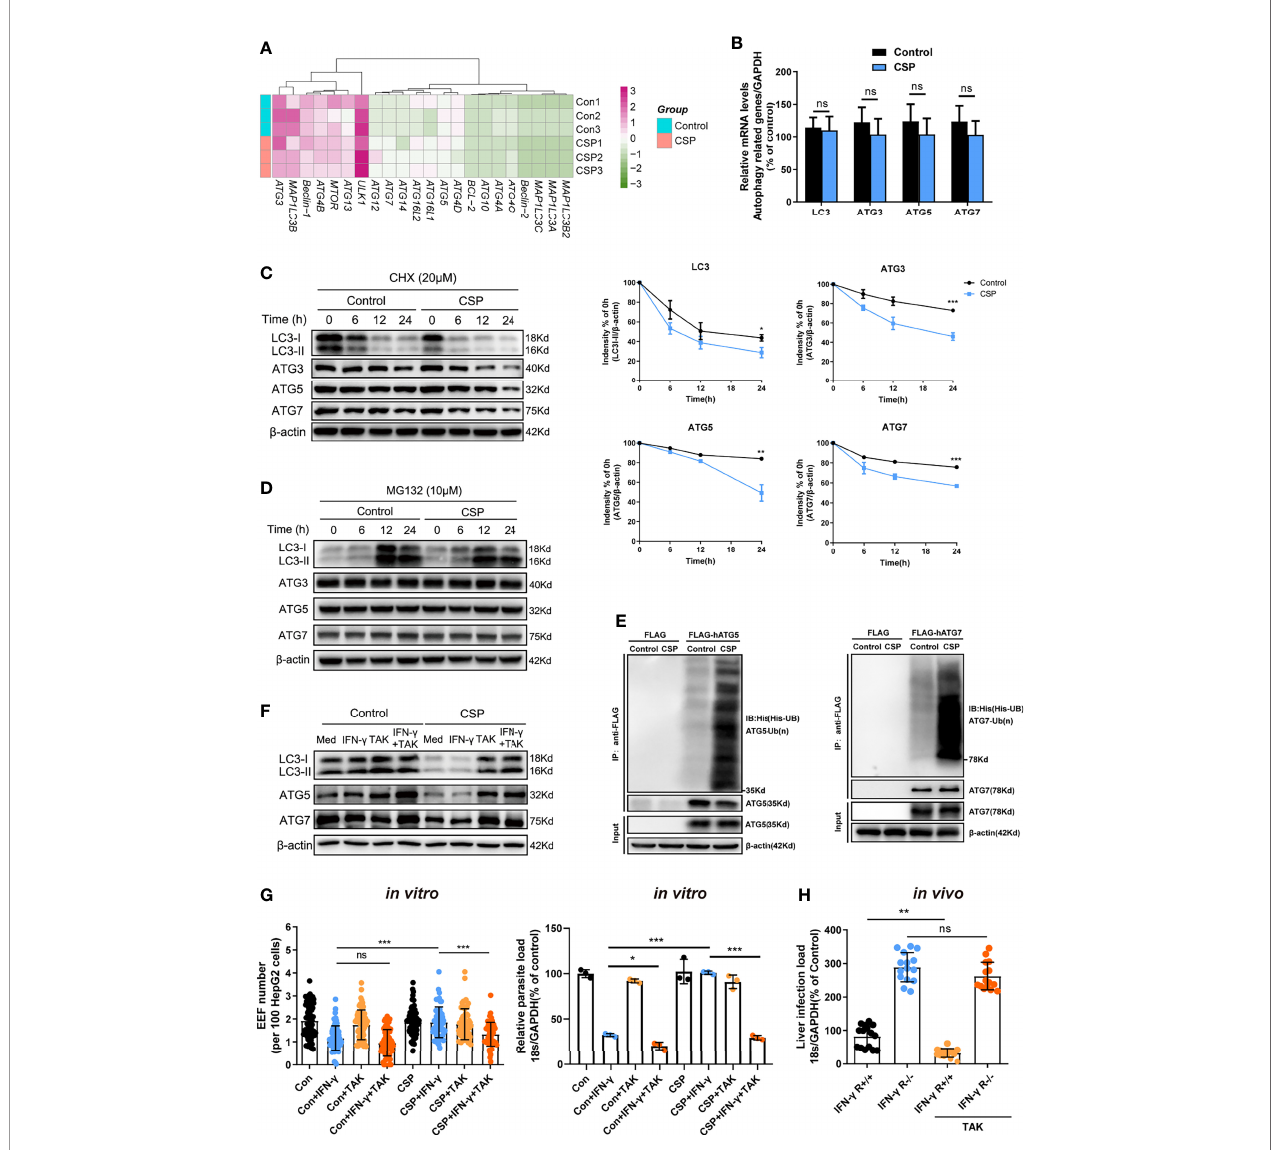
FIGURE 4 | The CSP-mediated resistance to IFN- g - killing of EEFs through the enhance of ATGs ubiquitination. (A) The mRNA levels of ATGs between control and CSP-stably transfected HepG2 cells in the heatmap were compared, and three biological repeats were performed. (B) The different mRNA levels of ATGs (ATG3, ATG5, ATG7, and LC3) between control and CSP-stably transfected HepG2 cells were compared using real-time PCR. Three individual experiments have been performed . (C) Control and CSP-stably transfected HepG2 cells were treated with CHX for the indicated times, and the protein levels of LC3I/LC3II, ATG3, ATG5 and ATG7 were detected by western blotting ( left ); the relative expression levels of LC3I/LC3II, ATG3, ATG5, and ATG7 to b -actin were quanti fi ed ( right ). Three individual experiments have been performed. (D) Control and CSP-stably transfected HepG2 cells were treated with the proteasome inhibitor MG132 for the indicated times, and the protein levels of LC3I/LC3II, ATG3, ATG5, and ATG7 were detected by western blot. The experiment have been performed for three times. (E) Ubiquitination assay showed that CSP promoted the ubiquitination of ATG5 ( left ) and ATG7 ( right ). Control and CSP-stably transfected HepG2 cells were transfected with His-UB, and FLAG-hATG5 or FLAG-hATG7 plasmids, and treated with MG-132 for 24 h. Then, cells were collected for immunoprecipitation of FLAG-hATG5 and FLAG-hATG7 followed by immunoblot analyses of ubiquitin (His-UB). Cells transfected with FLAG vector was used as negative controls. Total cell lysates (input) were also immunoblotted with antibodies against FLAG and b -actin. The experiment has been repeated for three times. (F) The levels of protein LC3, ATG5 and ATG7 were determined by western blotting in both control and CSP-stably transfected HepG2 treated with or without 1 m M TAK (TAK-243) and 1 U/mL IFN- g for 24 h. (G) 1.2 × 10 5 CSP-stably transfected HepG2 or control cells were treated with or without 1 m M TAK (TAK-243), and then were treated with 1 U/mL IFN- g and infected with 4 × 10 4 CSP wt sporozoites for 46 h. The EEF number ( left , each dot represents one visual fi eld, n=57-73, magni fi cation, 630×) and parasite load ( right ) were determined and compared as above. Three individual experiments have been performed (H) IFN- g R1 knockout and WT mice were per-treated with or without 20mg/kg TAK-243 and infected with 1,000 CSP wt sporozoites in the next day, then liver parasite burden was determined at 46 h after infection as described as above. Each dot represents one mouse (n=15). The pooled data of three repeated experiments was presented, data are represented as mean ± SD and analyzed by a student ’ s t-test or One-way ANOVA; ns, not signi fi cant; *P < 0.05; **P < 0.01; ***P <